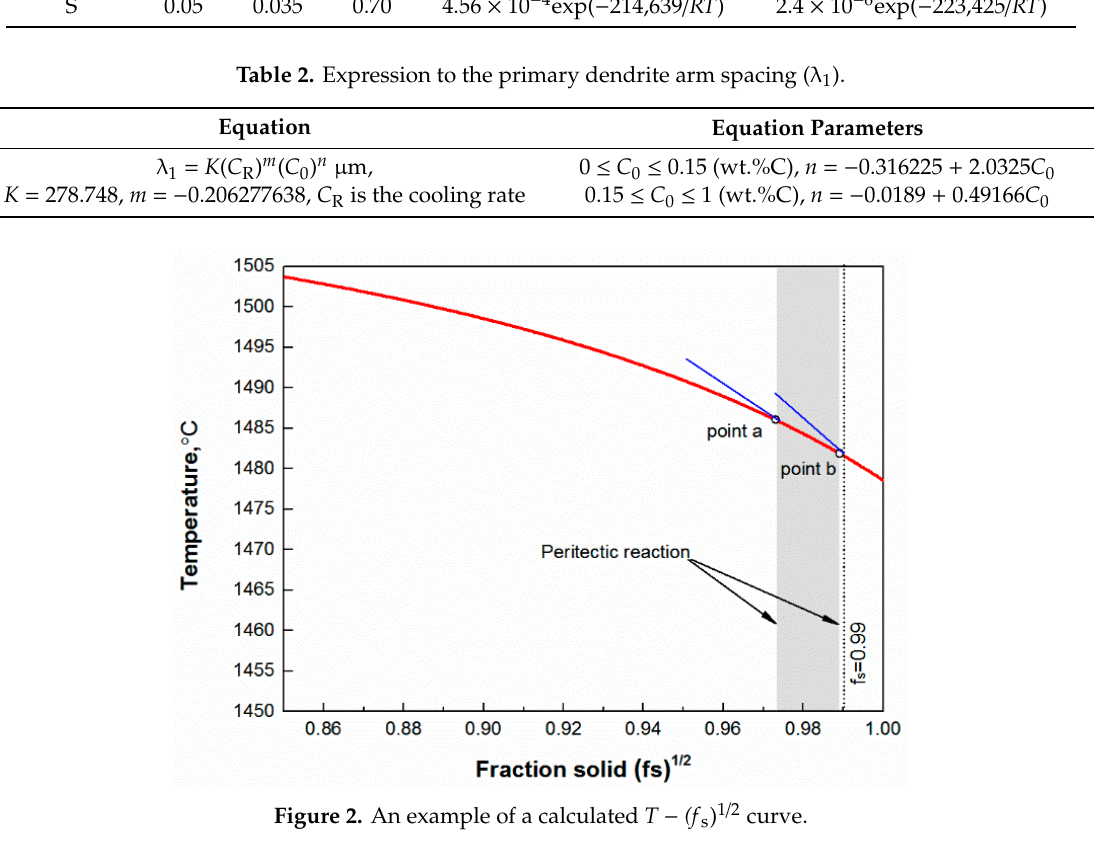
/ 2 the curve of T − (f s ) 1 is calculated, the range of peritectic solidification should be determined first, Table 1. Distribution coefficients and diffusion coefficients of elements in steel. / 2 | and then the | d T / d( f s ) 1 from point a to b on the curve of T − (f s ) 1 Element fraction interval of 0.005. The average value of | d T / d( f s ) 1 Table 1. Distribution coe ffi cients and di ff usion coe ffi cients of elements in steel. Element